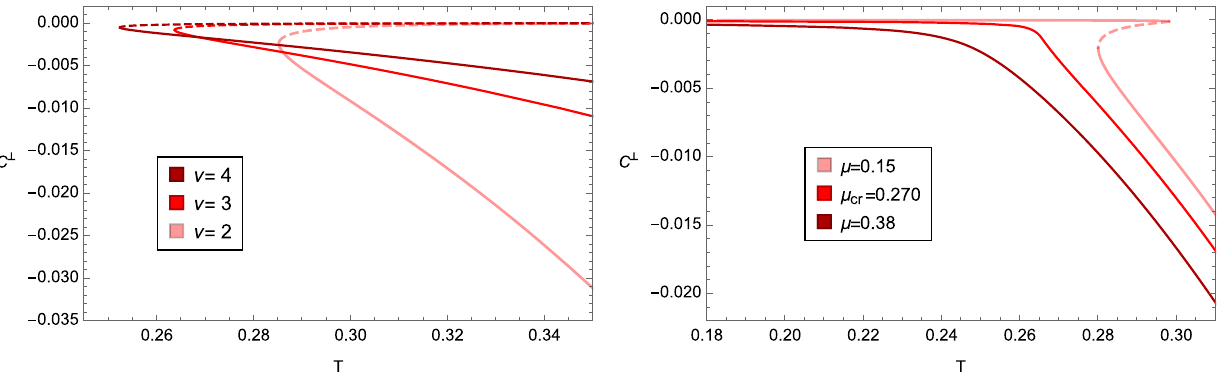
Fig. 9 Left: C ⊥ as a function of T for three values of ν for l = 0 . 5 at μ = 0. Right: C ⊥ in terms of T for different values of μ at l = 0 . 5 and ν =